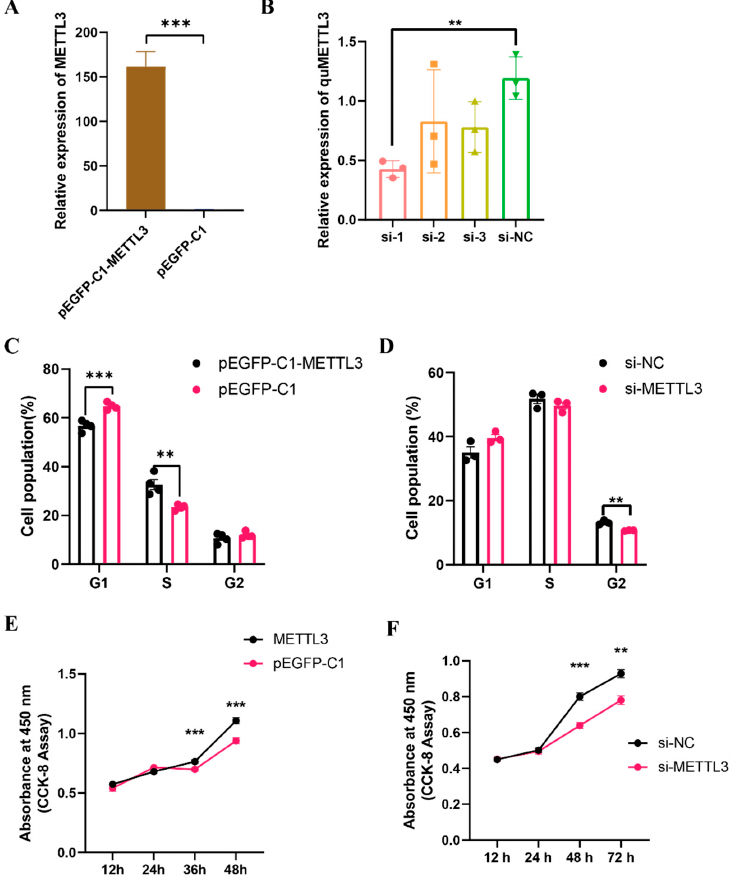
Figure 3. METTL3 enhances the proliferative ability of QM7 cells. ( A , B ) The relative expression level of METTL3 after the overexpression ( A ) and knockdown ( B ) of METTL3. ( C ) Cell cycle analysis of QM7 cells after the transfection of pEGFP-C1-METTL3 or pEGFP-C1. ( D ) Cell cycle analysis of QM7 cells after the transfection of siRNA targeting METTL3 (si-1) or the negative control (si-NC). ( E , F ) CCK-8 assay in QM7 cells after the overexpression or knockdown of METTL3 . ** indicates p < 0.01; *** indicates p < 0.001. 3.5. The Regulatory E ff ect of METTL3 Protein in QM7 Cell Di ff erentiation The mRNA expression level of METTL3 gradually decreased during the proliferation phase (GM) and various stages of di ff erentiation (DM1–DM5) in QM7 cells (Figure 4A), suggesting that METTL3 plays an important role in myoblast di ff erentiation. The overex- pression of METTL3 signi fi cantly increased the expression levels of myogenic and fusion marker genes ( MYOG , MYOD , and MEF2C ) (Figure 4B), whereas the opposite was seen with METTL3 knockdown (Figure 4C). These results indicated that METTL3 can promote di ff erentiation in QM7 cells.